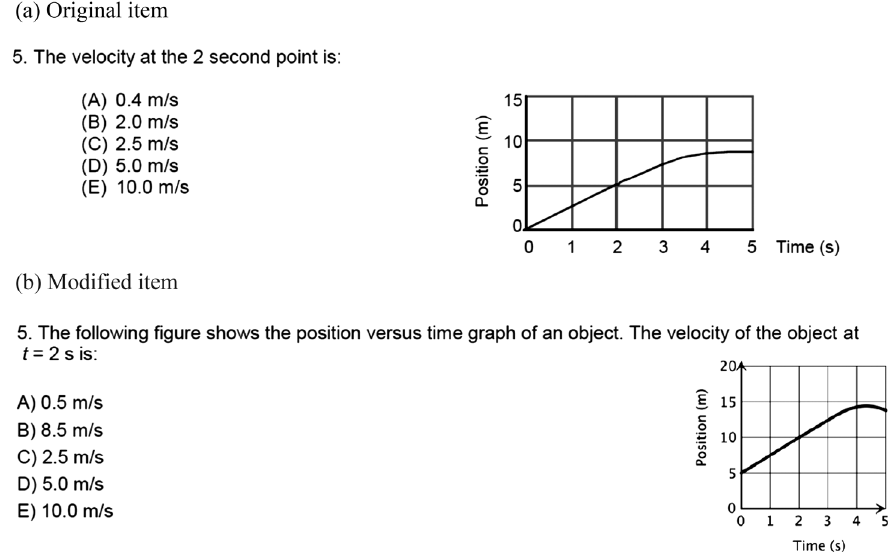
FIG. 1. Original version and modified version of item 5.